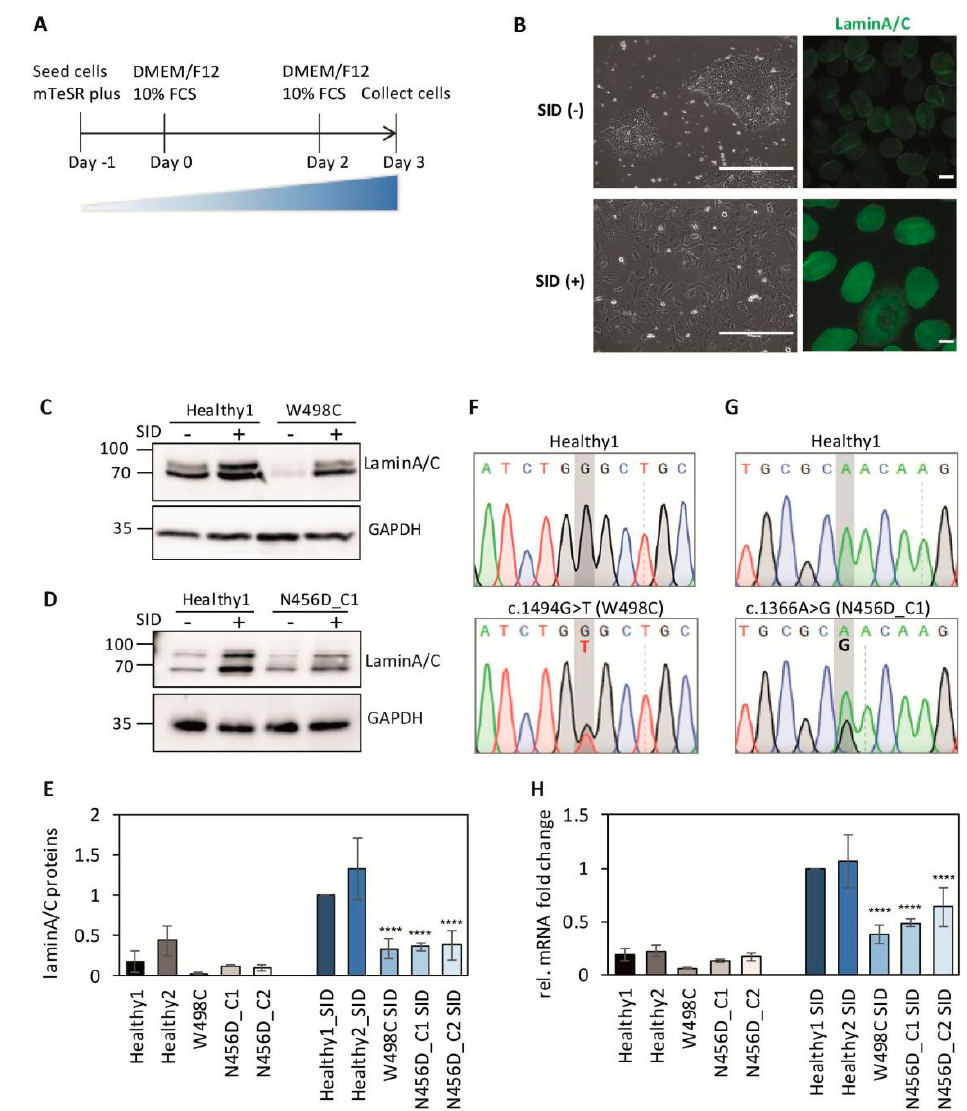
Figure 2. Impaired expression of LMNA after serum-induced differentiation in patient-derived iPSCs. ( A ) Scheme of SID protocol. ( B ) Unstained and stained iPSC LMNA N456D_C1 cells prior to and after SID, prior to SID as SID( − ) and after SID as SID(+). Cells were stained with anti − lamin A/C antibody (green). Scale bar for unstained images 400 μ m, for stained images 10 μ m. ( C – E ) Western blot of lamin A/C protein expression in healthy and patient iPSCs prior to and after SID (N = 3; p < 0.0001, ****). A second healthy control iPSC and a second clone for patient iPSC LMNA N456D were also included (Figure S2D) for quantification, and the level of healthy1 after SID was used as reference, with grey bars as prior to SID and blue bars are SID. ( F – H ) LMNA mRNA expression in healthy and patient iPSCs prior to and after SID (N = 3; p < 0.0001, **** except N456D_C2 p < 0.001, ***). Sequencing results of reverse transcription (RT) products from mRNAs of healthy and patient iPSC prior to SID. The sequencing results after the SID can be seen in Figure S3. For quantification, the level of healthy1 after SID was used as reference with grey bars prior to SID, while blue bars are SID. Healthy1 and healthy2: two healthy controls hiPSC LMNA_WT/LMNA_WT ; W498C: patient hiPSCs LMNAc.1494G>T/LMNA_WT ; N456D_C1 or C2: patient hiPSCs LMNAc.1366A>G/LMNA_WT clone 1 or clone 2. 3. Impaired Expression of LMNA Co − Regulated Genes after SID in Patient − Derived iPSCs Published RNA − seq data [13] indicated that LMNA mRNA expression rose early in co − regulated genes, such as COL1A2 , COL4A1 , S100A4 , S100A6 , S100A10 (Xi et al. [13],